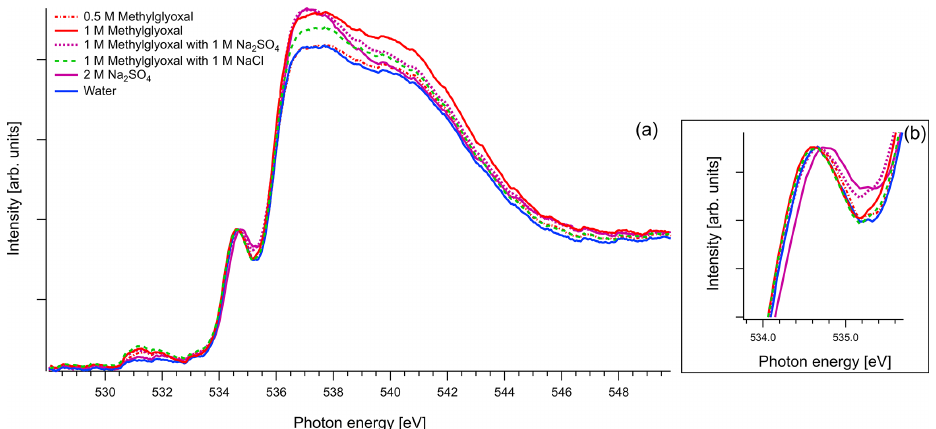
Figure 7. (a) O K-edge spectra of binary aqueous solutions of methylglyoxal and ternary aqueous solutions containing 1M of methylglyoxal with 1M of Na 2 SO 4 or 1M of NaCl. We also present the recorded spectra of pure water and binary water–2M Na 2 SO 4 solution. All the spectra are normalized to the pre-peak at 535eV. (b) Zoom on the pre-peak of the